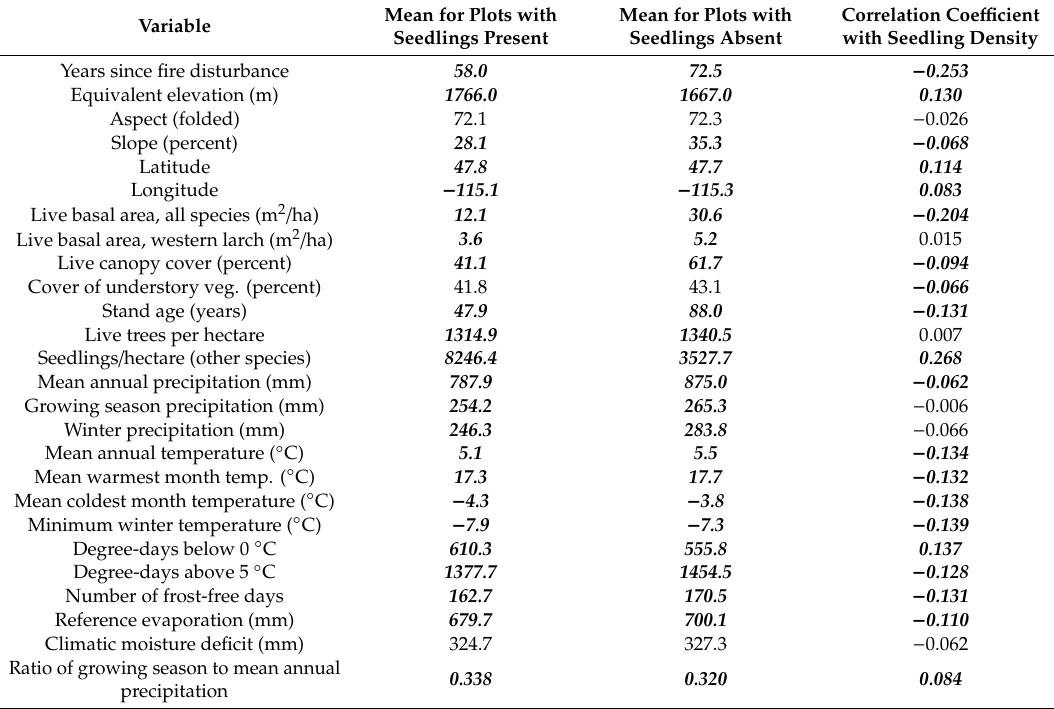
Table 4. Summary statistics of 26 continuous predictor variables for plots with and without western larch seedlings present. Predictors with significantly di ff erent values between plots with and without seedlings present according to Wilcoxon rank sum tests ( α = 0.05) and significant correlation coe ffi cients ( α = 0.05) are also indicated in bold and